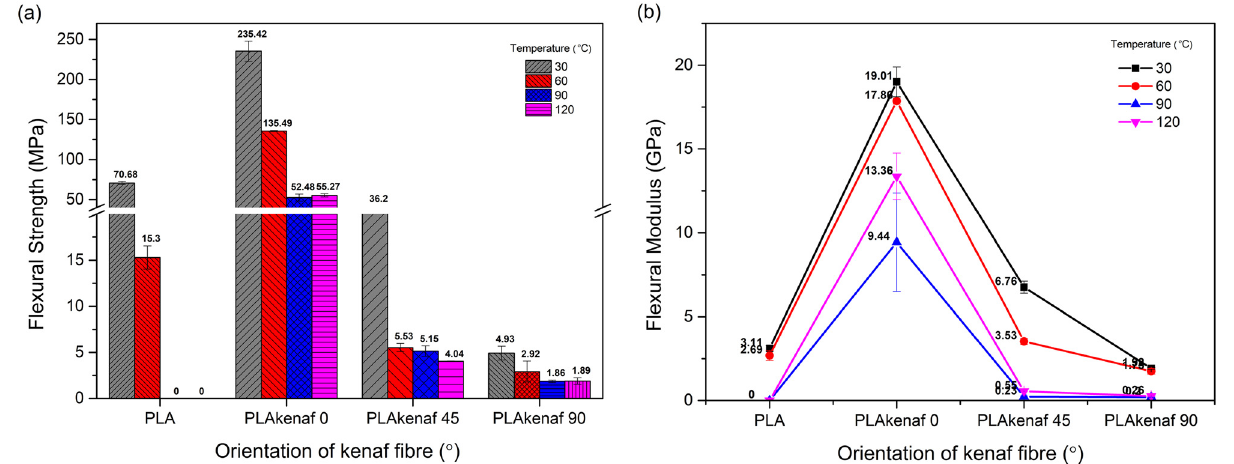
Figure 8: ( a ) Flexural strength and ( b ) modulus of pure PLA and PLA – kenaf composites at di ff